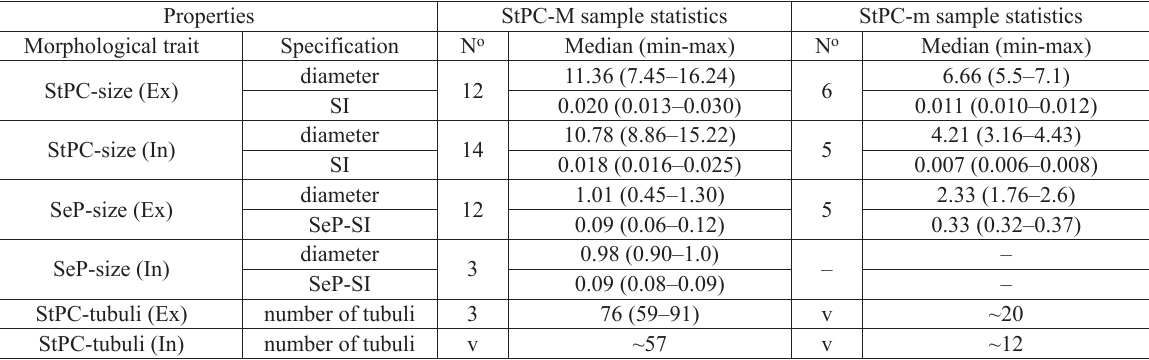
Table 1. Characterization of sieve-type normal pore canals (StPC) of Minyocythere macroporosa sp. nov. Abbreviations: StPC-M, macro sieve- type pore canals; StPC-m, micro sieve-type pore canals; Ex/In, view of the trait on the external/internal side of the valve; SI, Size Index (ratio of the pore diameter to the valve’s length); SeP, setal pore of the StPC; SeP-SI, Setal Pore Size Index (ratio of the SeP diameter to the StPC diameter); diameter (in μ m), expressed either as individual value or through the median statistics and min-max values; N o , number of observations; v, variate (single